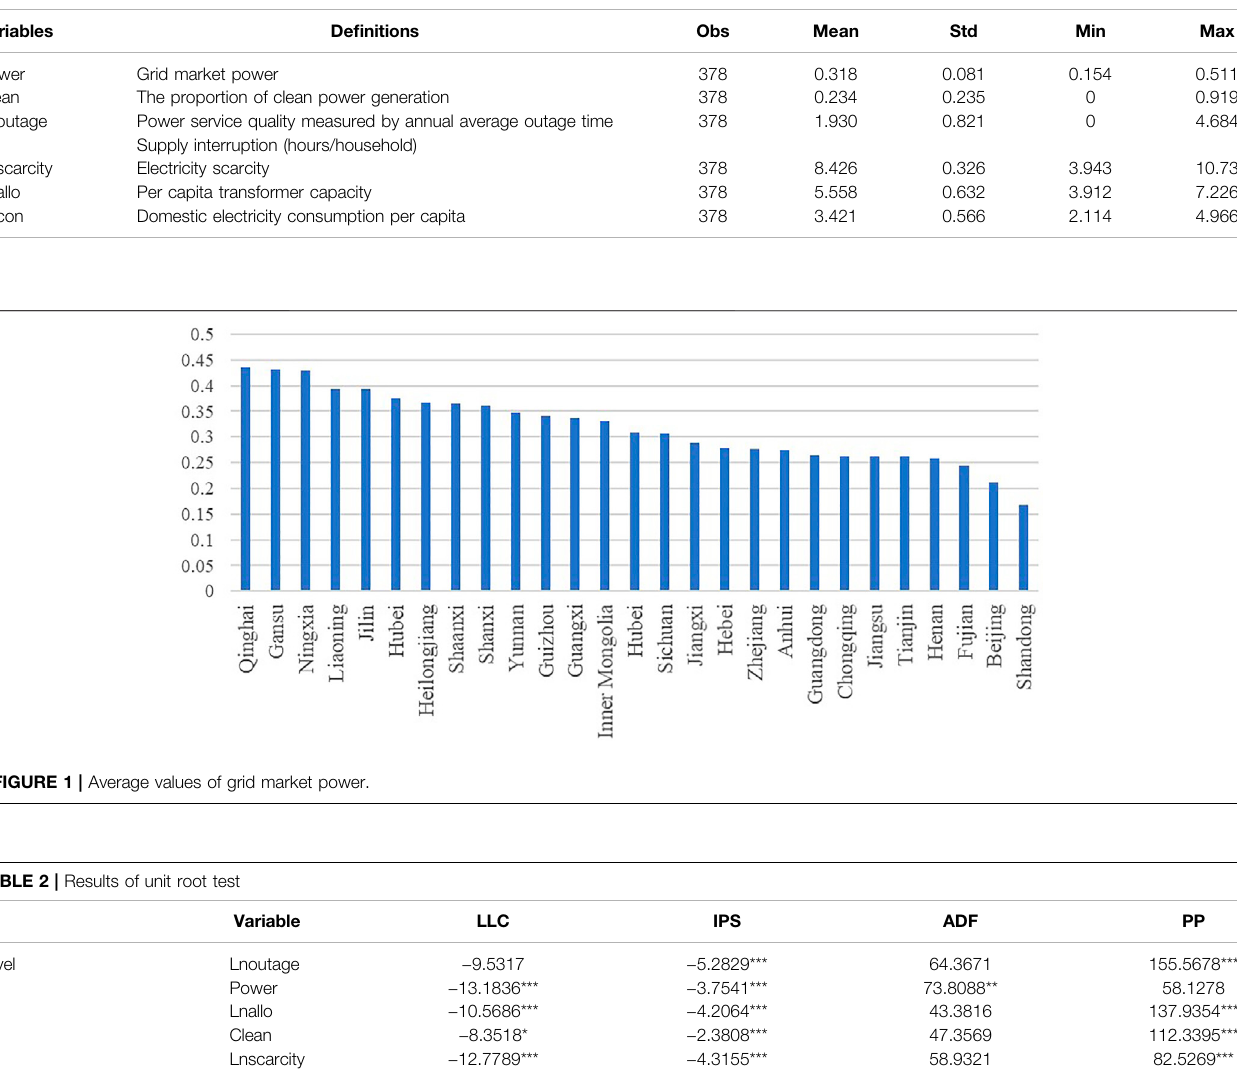
TABLE 1 | Description of variables